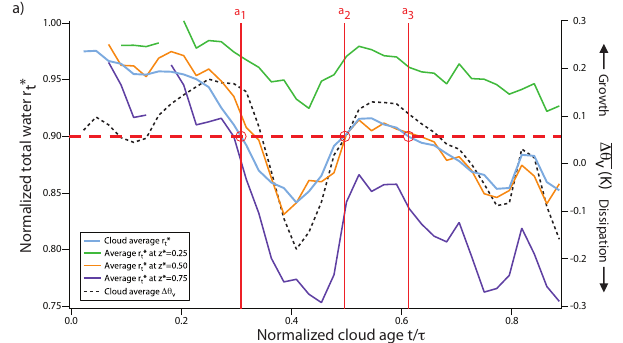
Figure 10. Time series of r ∗ t averaged over the entire cloud and at individual levels. Cloud average 1θ v is shown for